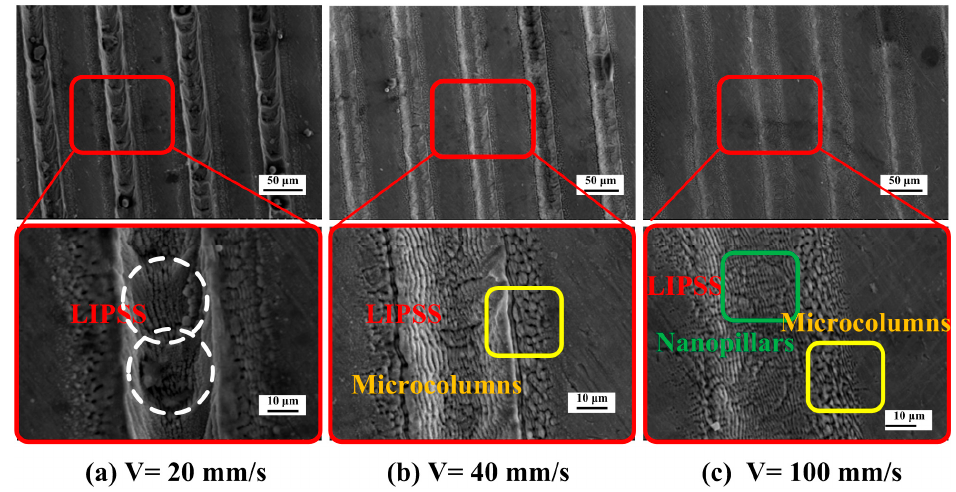
Figure 7. Effect of scanning speed on the morphology of LIPSS (defocusing amount L is 1 mm, laser energy density is 0.107 J/cm², the pulse frequency is 0.1 MHz, the single pulse energy is 75 μ J). The scanning speed is ( a ) V= 20 mm/s; ( b ) V= 40 mm/s; ( c ) V= 100 mm/s.